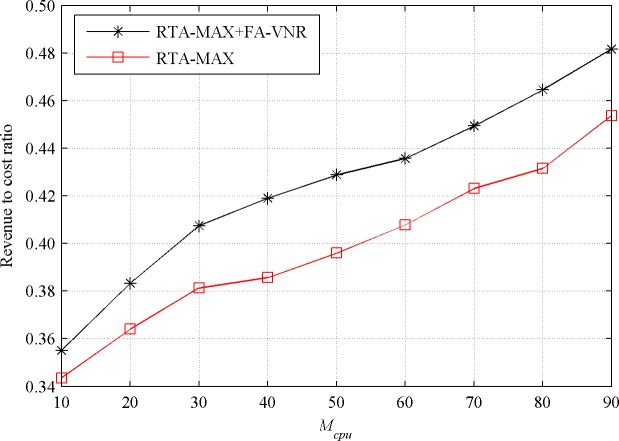
Revenue to cost ratio with increasing Mcpu.